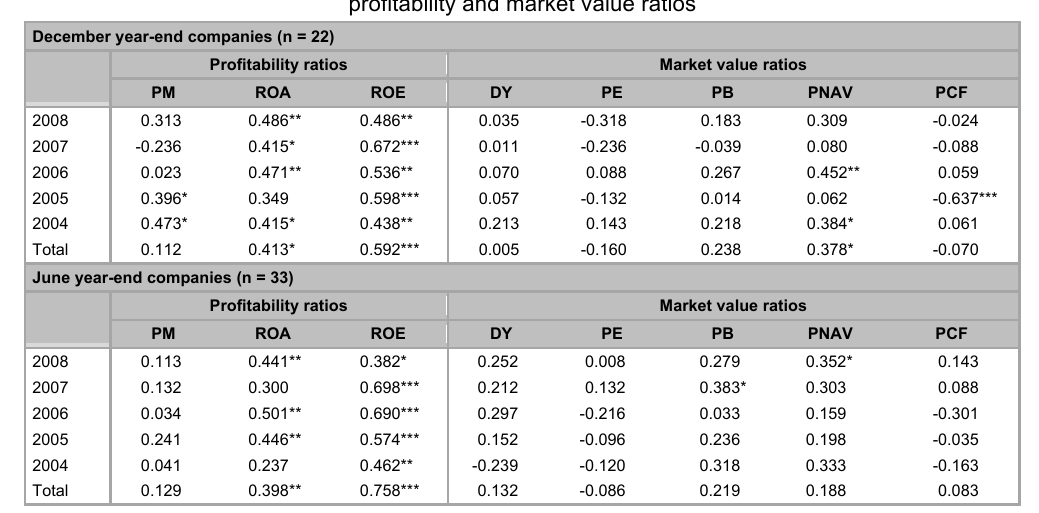
Table 3 indicates Spearman’s correlation coefficient between technical efficiency and